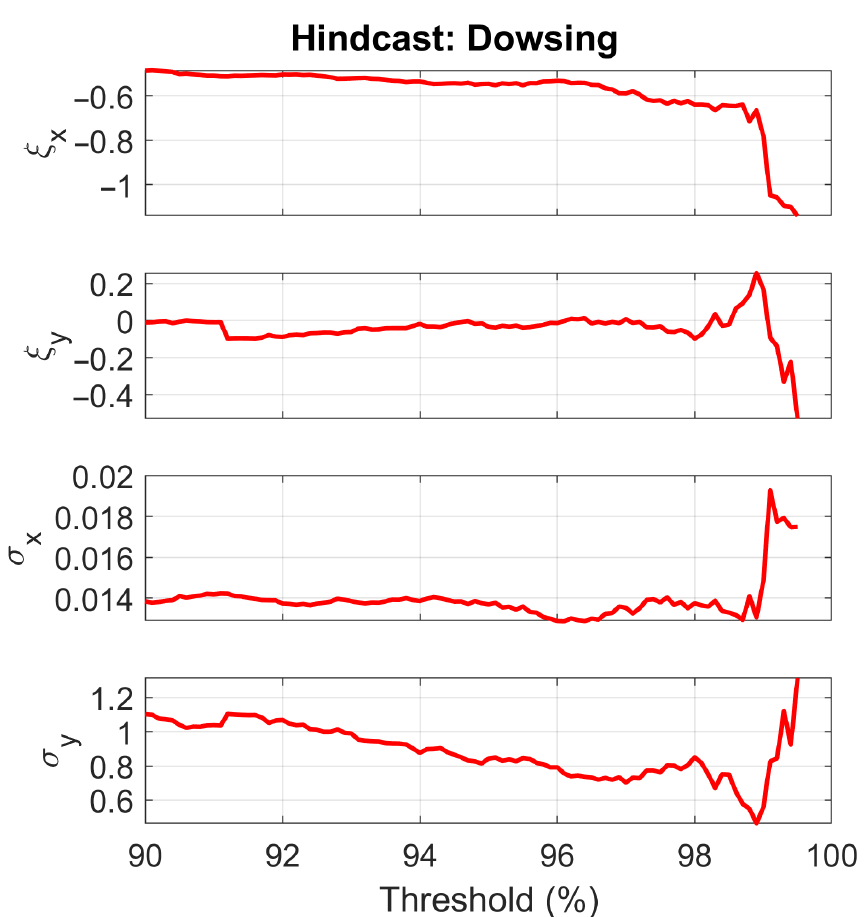
Figure 9. A threshold plot utilized in choosing the thresholds for the 2D POT method. The upper two subplots show how the Generalized Pareto-parameter ξ varies with the choice of threshold for the hindcast data at Dowsing, both for the steepness ( ξ x ) and for the wave height ( ξ y ). Correspondingly the lower two subplots show how the parameter σ varies with